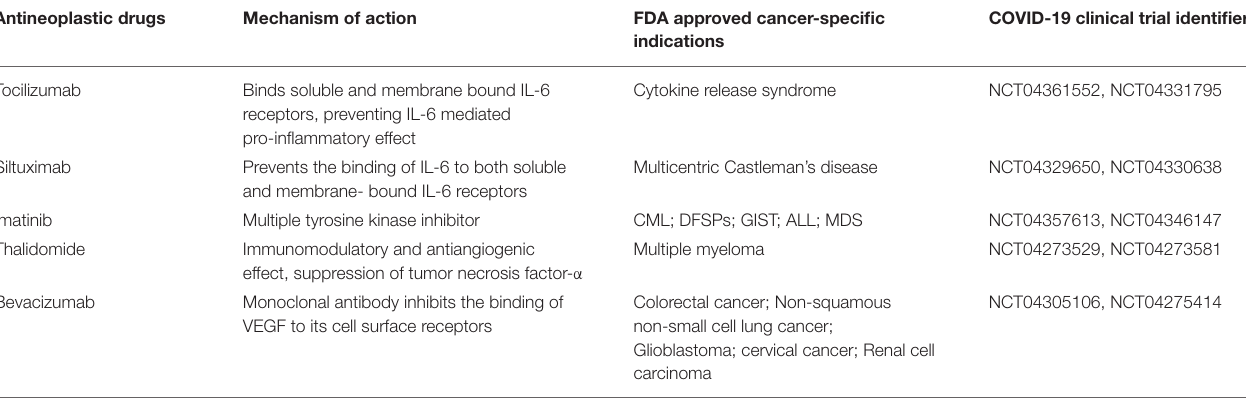
TABLE 2 | FDA-approved antineoplastic drugs repurposed for COVID-19 treatment. Antineoplastic